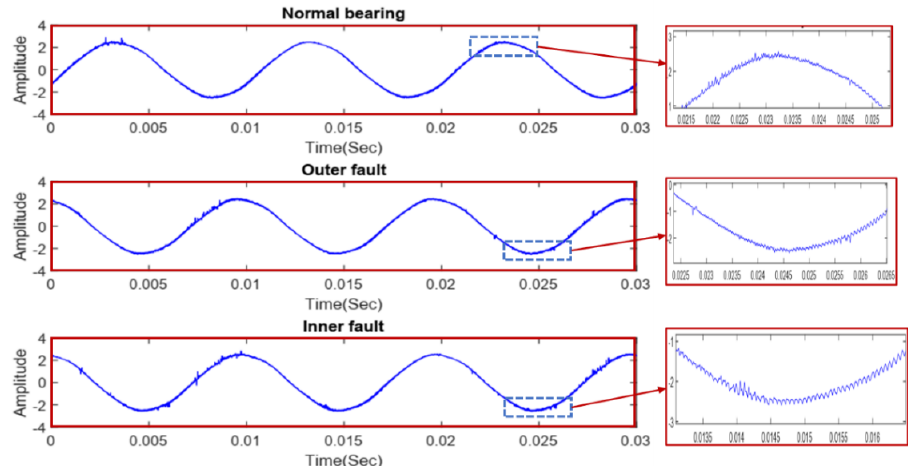
Figure 6. The time − domain representation of the three considered bearing conditions.